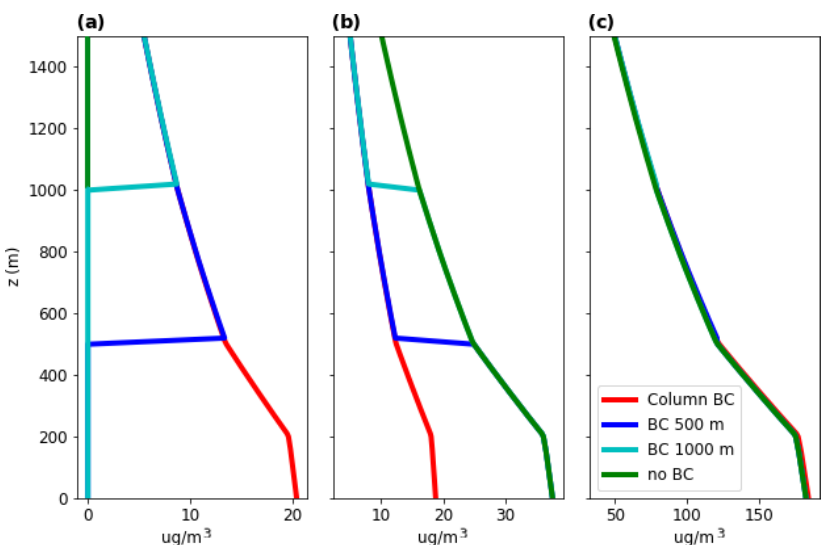
− and (c) total aerosol for each of the experiments outlined. For simulations with Figure 4. Initial mass concentrations of (a) BC, (b) SO 2 4 the same aerosol concentration but varying composition across the column to have BC through the column (red), BC above 500m (blue), BC above 100m (cyan) and no BC throughout the column (green). Table 6. Maximum sensible heat flux (SHF), planetary boundary layer (PBL) height (taken as the height with the largest gradient in θ ), surface temperature ( T ), downwelling shortwave radiation ( ↓ SWR) at the surface, upwelling shortwave radiation ( ↑ SWR) at model top (1800m) and air temperature ( T ) at 10m. Values are the maximum between 12:00 and 16:00 local standard time (LST). SHF PBL height Surface T ↓ SWR surface ↑ SWR